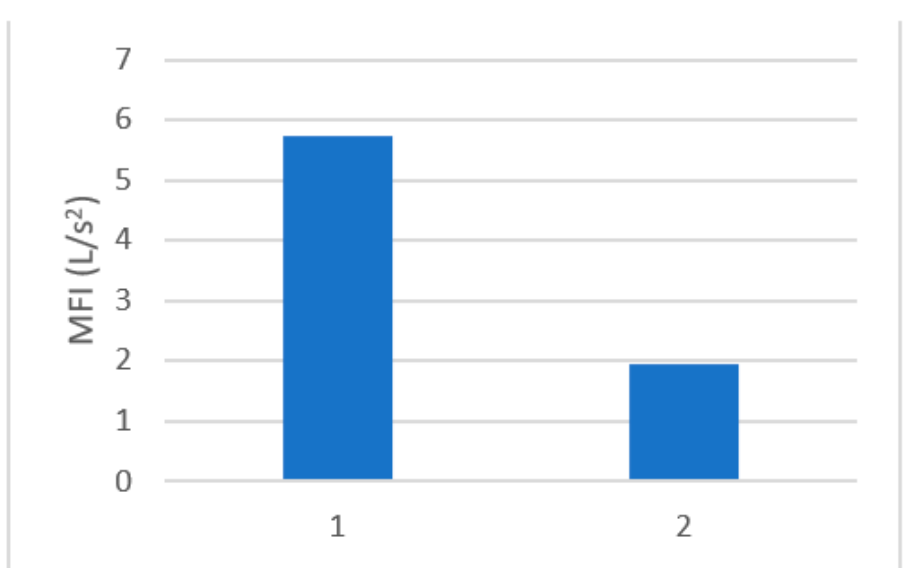
Figure 5. MFI for 1. Untreated mixed wastewater, 2. Pre-treated mixed wastewater.